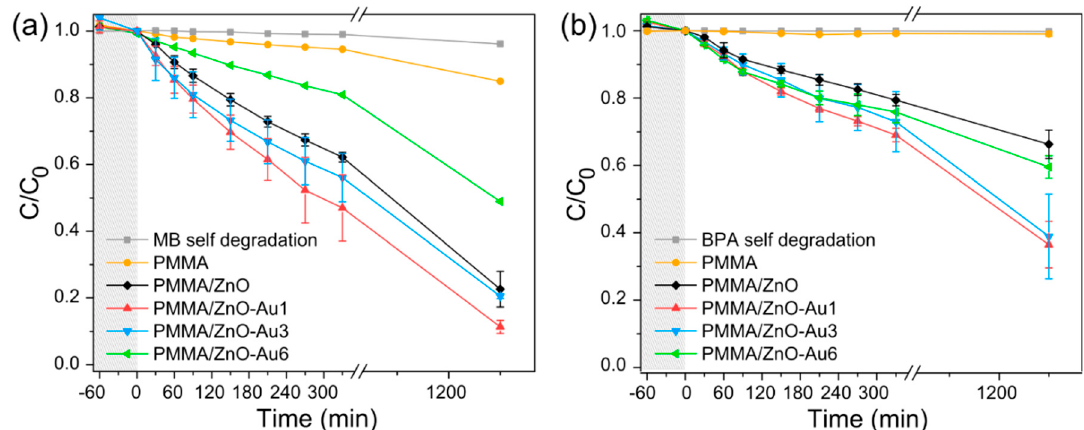
Figure 5. Photocatalytic degradation curves of ( a ) methylene blue (MB) and ( b ) bisphenol A (BPA) in presence of the composite mats under UV light. Before the UV irradiation, the solutions were kept in dark for 60 min in the presence of the composite mats. The self-degradation of MB and BPA under UV is also presented.